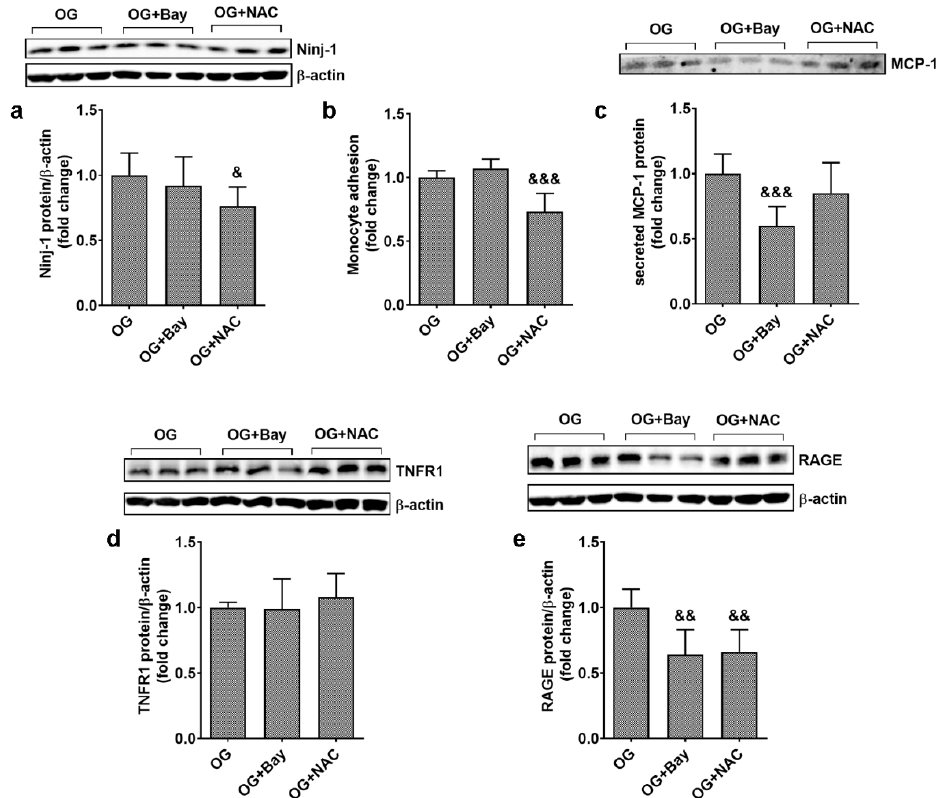
Figure 7. Inhibitors for oxidative stress and NF-kB reduce inflammation in ECs exposed to oscillating glucose. Cells were exposed alternatively to 5 mM/25 mM glucose (OG) at every 3 h, for 72 h. N-acetyl-cysteine (NAC, 7.5 mM) or Bay11-7085 (Bay, 15 µM) were added to the OG experimental condition, for the whole period of incubation. ( a , d , e ) Protein expression of Ninj-1 ( a ), TNFR1 ( d ) and RAGE ( e ) in EC lysates relative to β -actin (representative blot and densitometric analysis); ( b ) monocyte adhesion to endothelial cells; ( c ) secreted MCP-1 in the culture media relative to total cell protein (representative blots and densitometric analysis). All data are expressed as fold change versus OG and presented as mean ± SD. & p < 0.05, && p < 0.01, &&& p < 0.001 vs. OG.